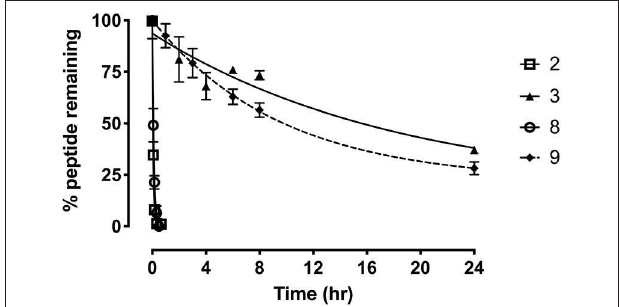
FIGURE 7 | Serum stability of the single-chain R3 B1-27 ( 2 ), Apa + R3B ( 3 ), R3 B1-22R ( 8 ), and Apa + R3 B1-22R ( 9 ) as measured in % peptide remaining in serum at various time points. Data presented as mean ± SEM from at least three